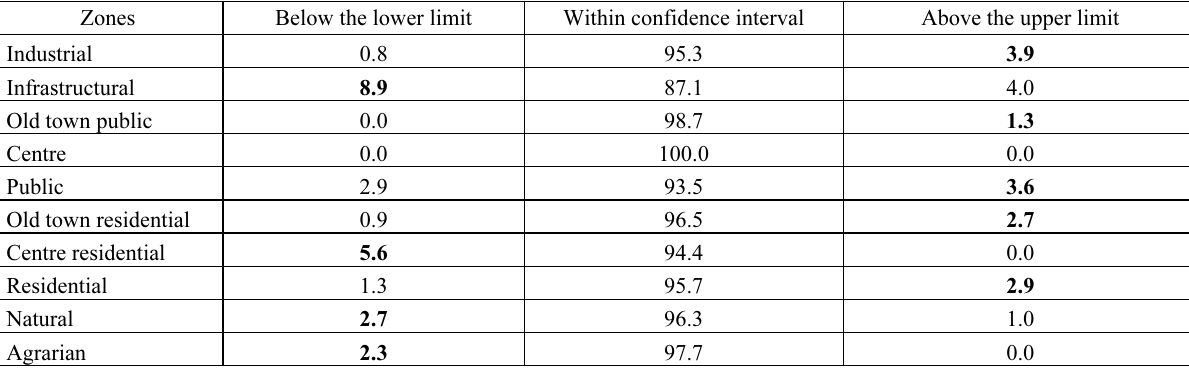
Table 4. Percentage of sites within and outside the prediction intervals for Zd Zones Below the lower limit Within confidence interval Above the upper